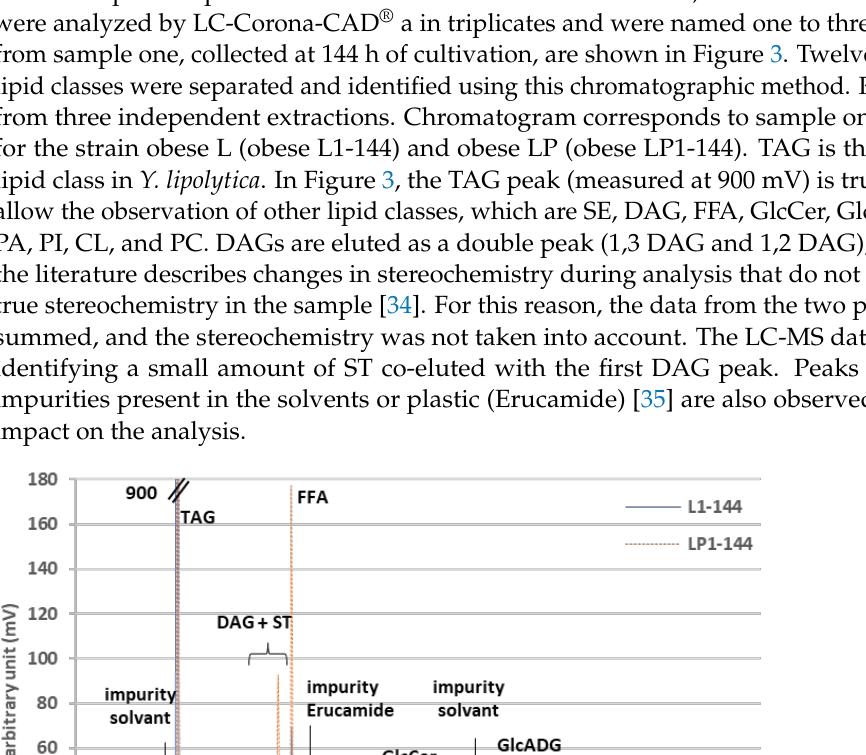
Figure 2. Growth and time-point sampling for lipidomic analysis. Two strains obese L (JMY7775) and obese LP (JMY7780) were grown in YNBDPA media at 28 °C. Samples for lipidomic analysis were taken at 72 h, 144 h, and 216 h (arrow). The corresponding samples were named L-72, L-144, L-216 and LP-72, LP-144, LP-216, respectively. Growth A600 is adapted from Park et al., 2021. Table 1. Biomass and lipid content from obese L and obese LP strains. The samples harvested at 216 h were used for the analysis of GC-FID. Samples